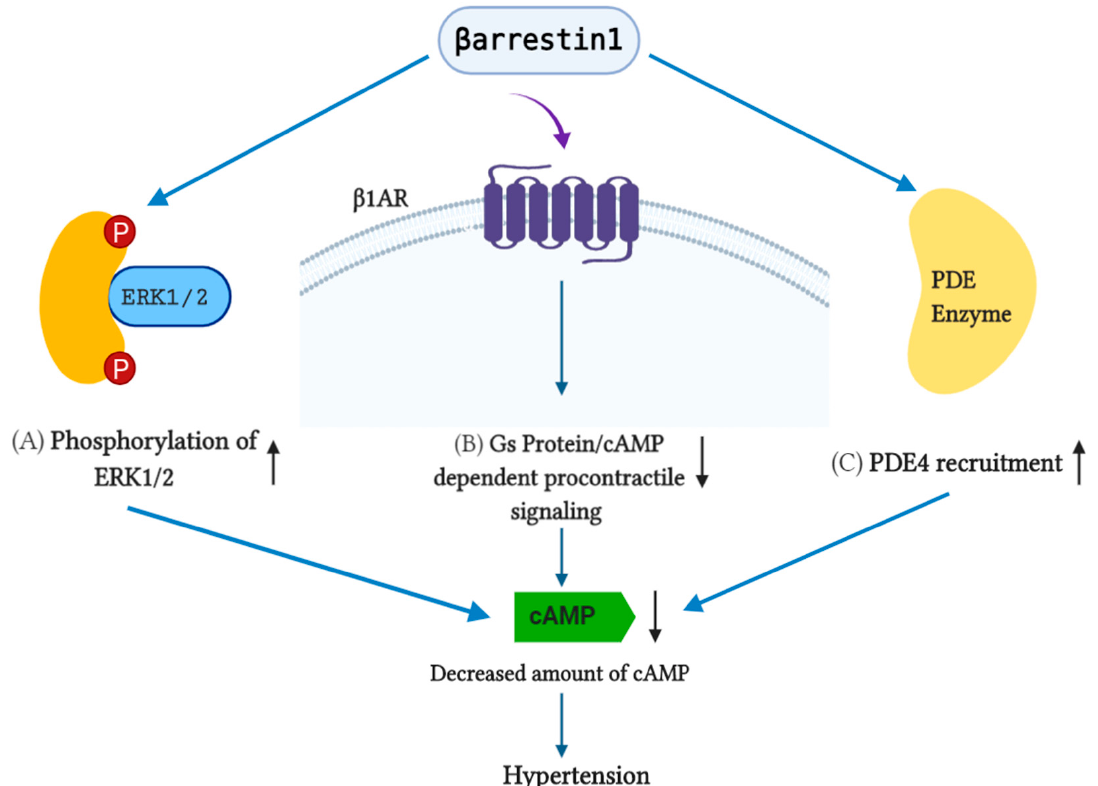
Figure 3. Effects of β -arrestin1 on the cellular cAMP level. ( A ) β -arrestin1 elevates the phosphorylation of ERK1/2, resulting in a decreased amount of cAMP. ( B ) β -arrestin 1 inhibits G s /protein/cAMP-dependent pro-contractile signaling, which eventually reduces the cellular cAMP level in β 1 AR. ( C ) β -arrestin1 involves PDE4 recruitment, ultimately causing a decreased cAMP level.